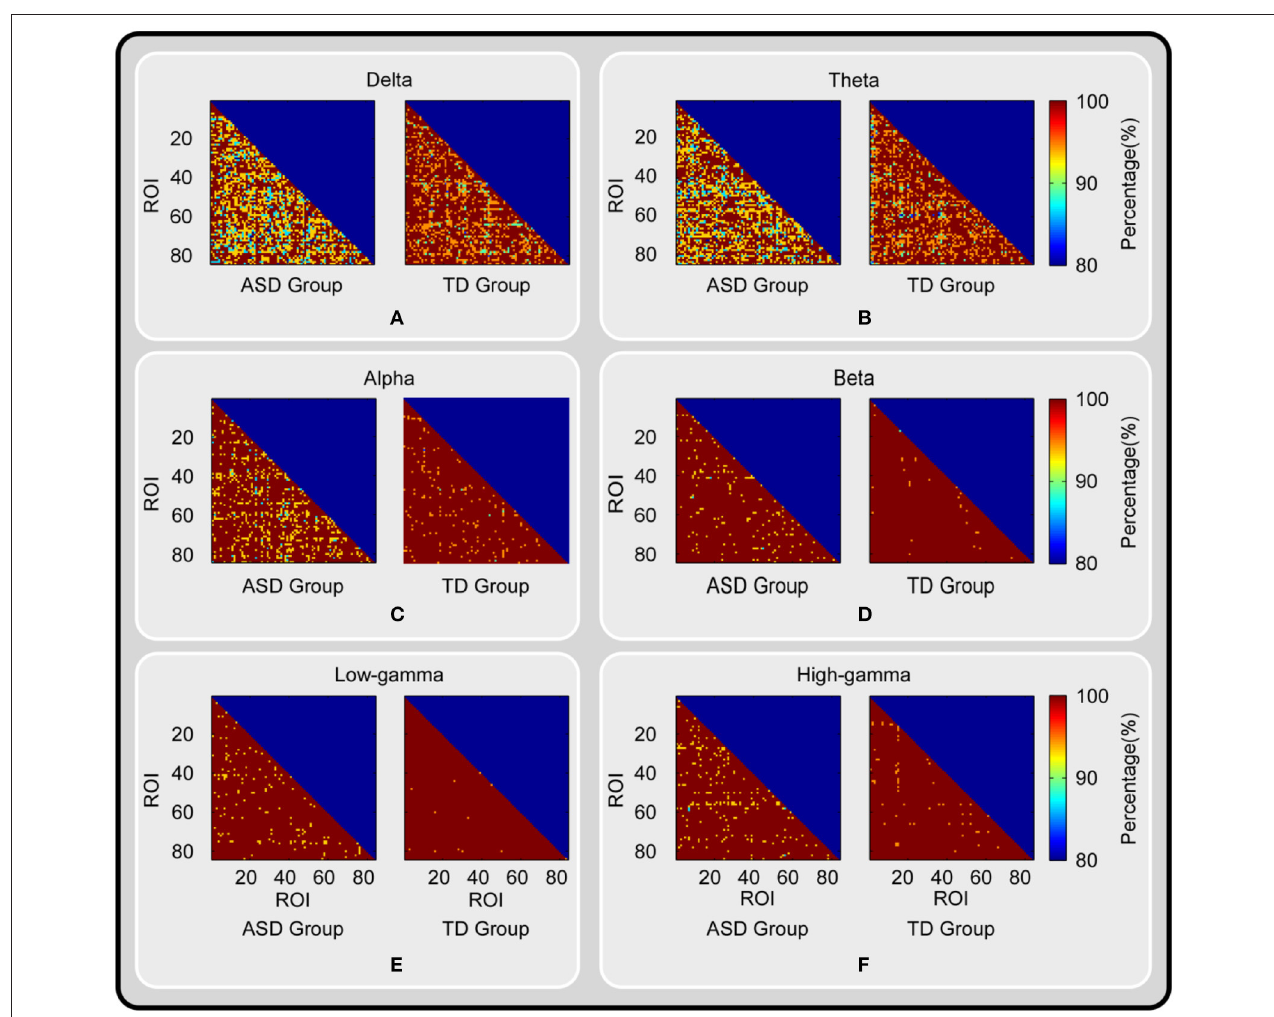
FIGURE 1 | The results of ML-DFA conducted on the TV-PS time series between brain oscillations. The percentage of participants for which the presence of scale-invariance was accepted for each ROI pair, each group and each frequency band is shown. The results for delta, theta, alpha, beta, low-gamma and high-gamma band are color coded and presented in panel (A-F)